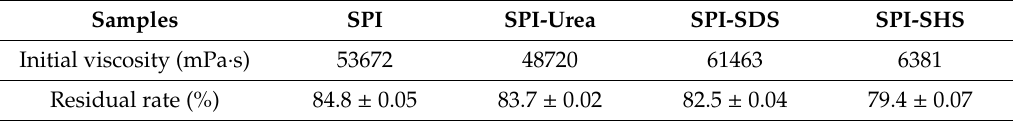
Table 3. The residual rate and initial viscosity of the cured adhesive samples.